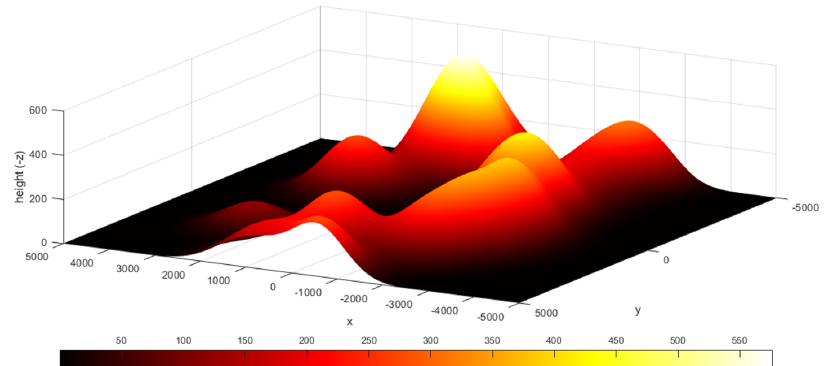
Figure 4. Three-dimensional visualization of terrain environment.